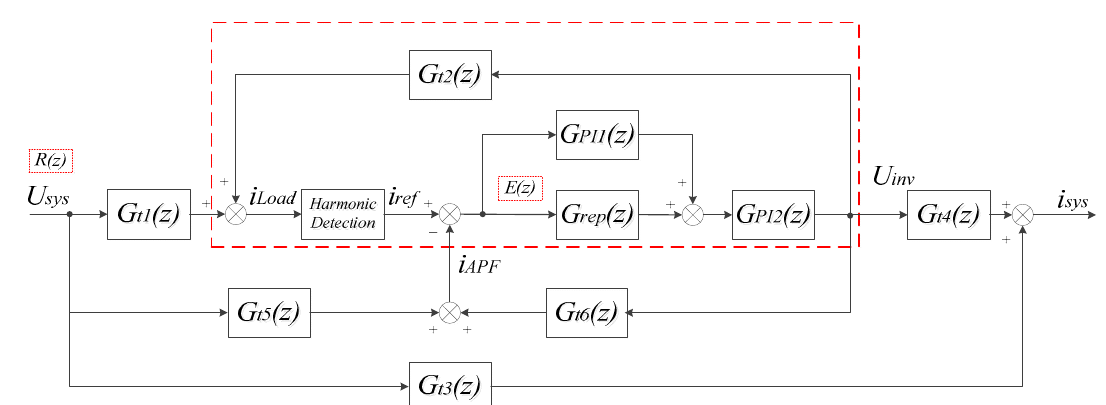
Figure 7. Modified model of shunt active power filter system.